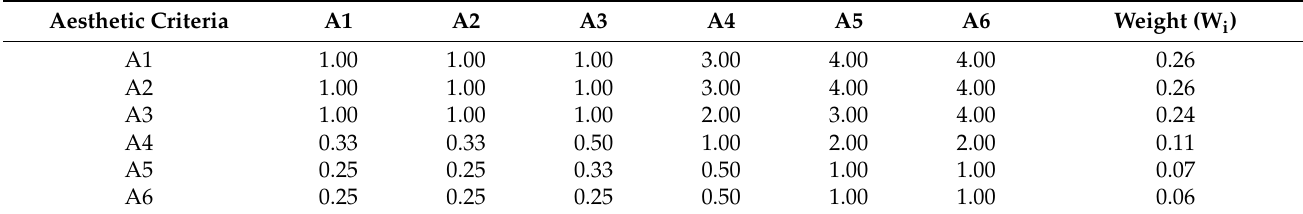
Table 9. Weights of aesthetic criteria of PV. Own